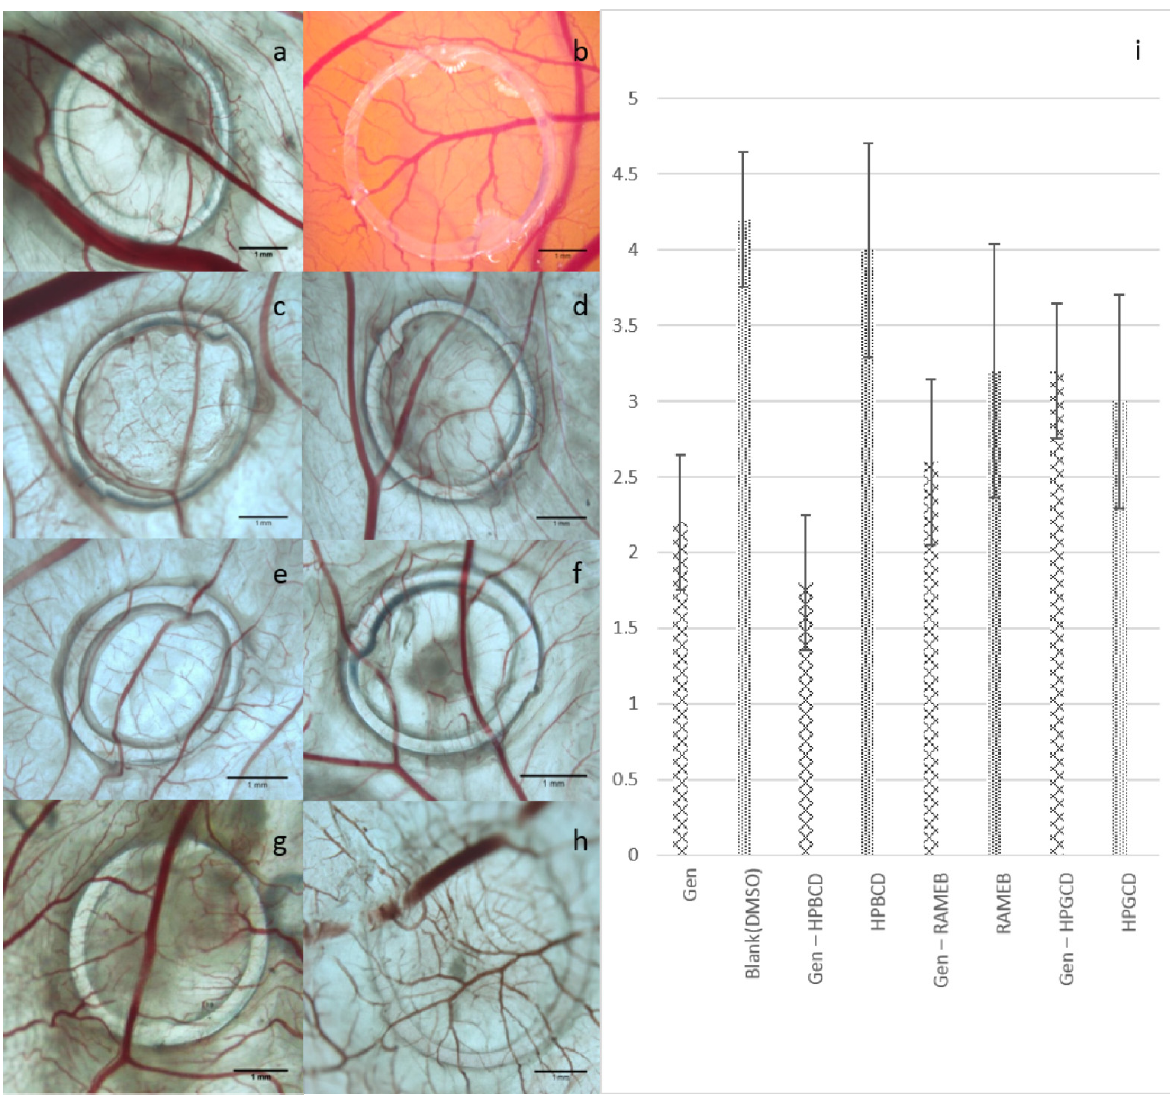
Figure 6. Effects on angiogenesis for genistein (Gen) and the tested complexes prepared with RAMEB (Gen-RAMEB), HPBCD (Gen-HPBCD) and HPGCD (Gen-HPGCD)